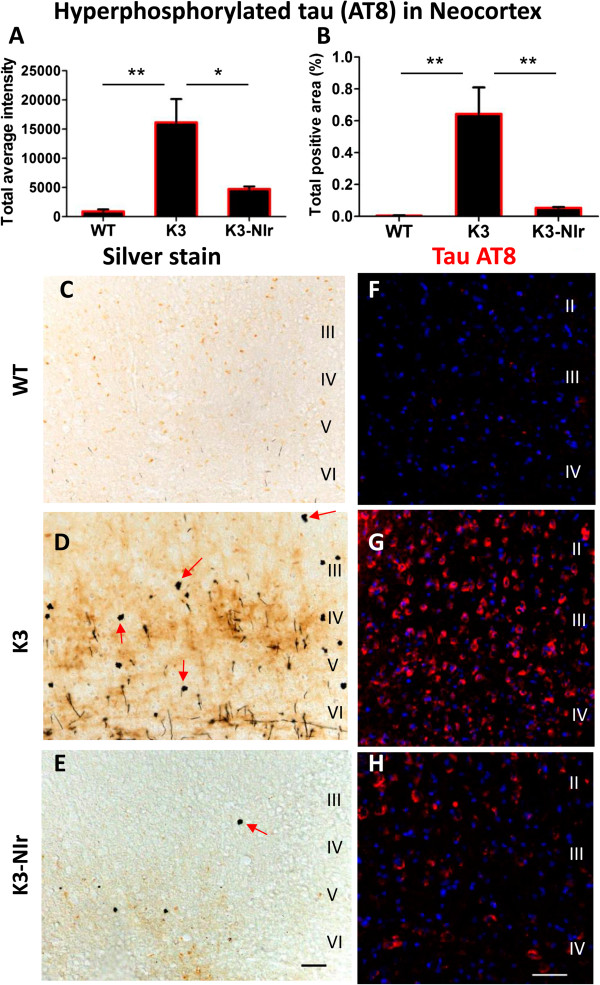
Effect of near-infrared light treatment on hyperphosphorylated tau and neurofibrillary tangles in the neocortex of K3 mice. (A), (B) Quantification of tau AT8 immunolabelling, based on average labelling intensity (A) and labelled area (B). All error bars indicate standard error of mean. *P < 0.05, **P < 0.01. (C), (D), (E) Representative photomicrographs of sections stained with Bielschowsky silver stain to demonstrate neurofibrillary tangles (NFTs). Arrows indicate axonal swellings and NFTs. (F), (G), (H) Representative micrographs of AT8 (red) labelling within neurons of the neocortex retrosplenial area. Nuclei were labelled with bisbenzimide (blue). Scale bars = 50 μm; scale in (E) applies to (C) and (D), scale in (H) applies to (F) and (G). NIr, near-infrared light; WT, wildtype.